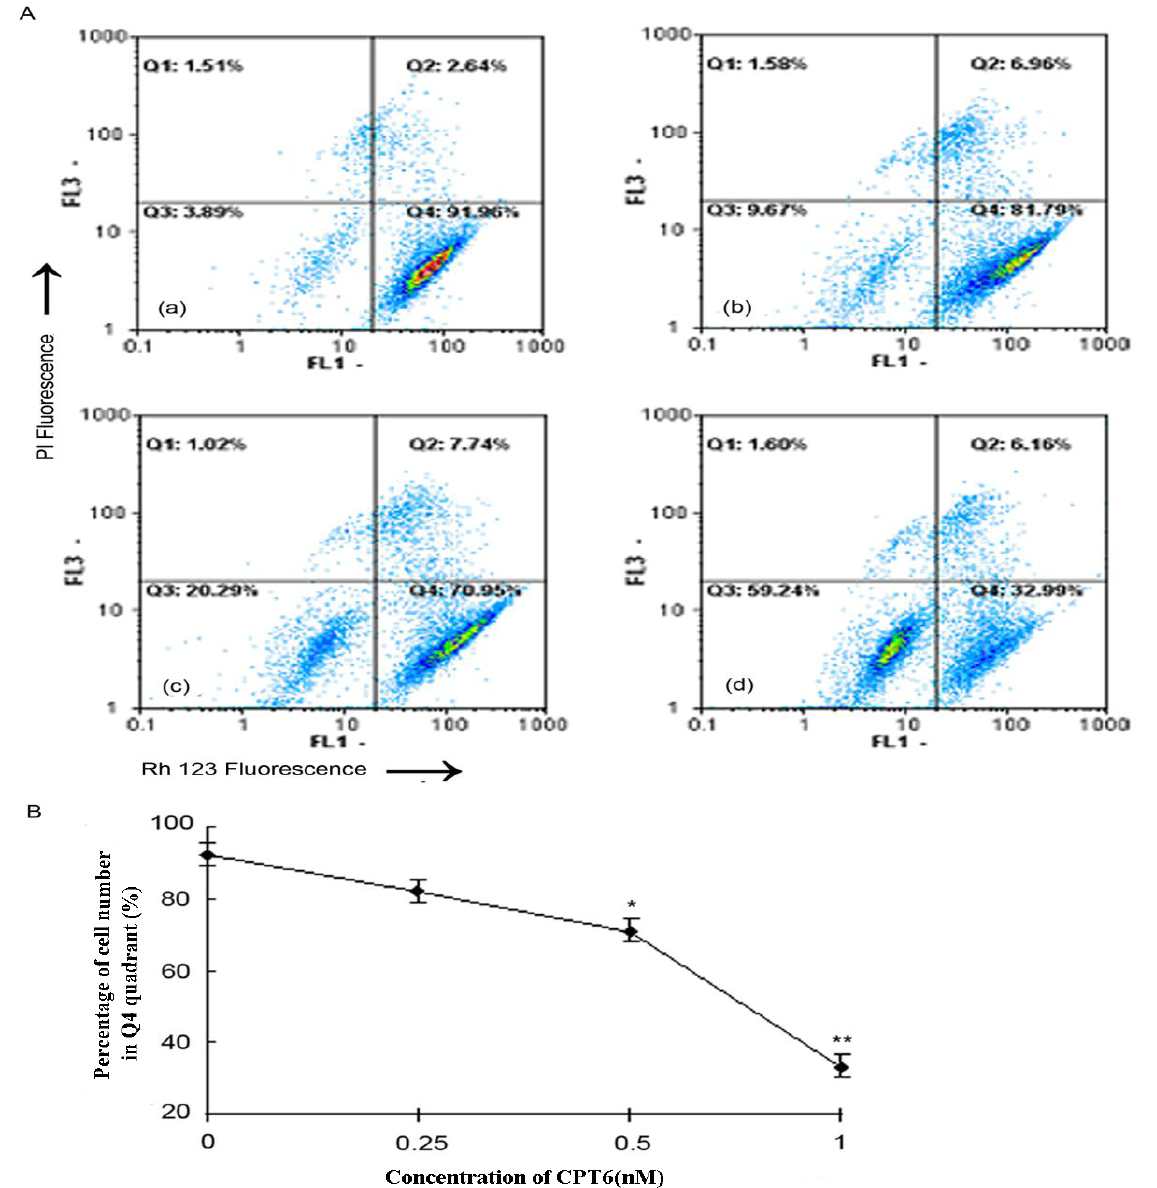
Figure 7. Flow cytometric analysis of the changes in the mitochondrial